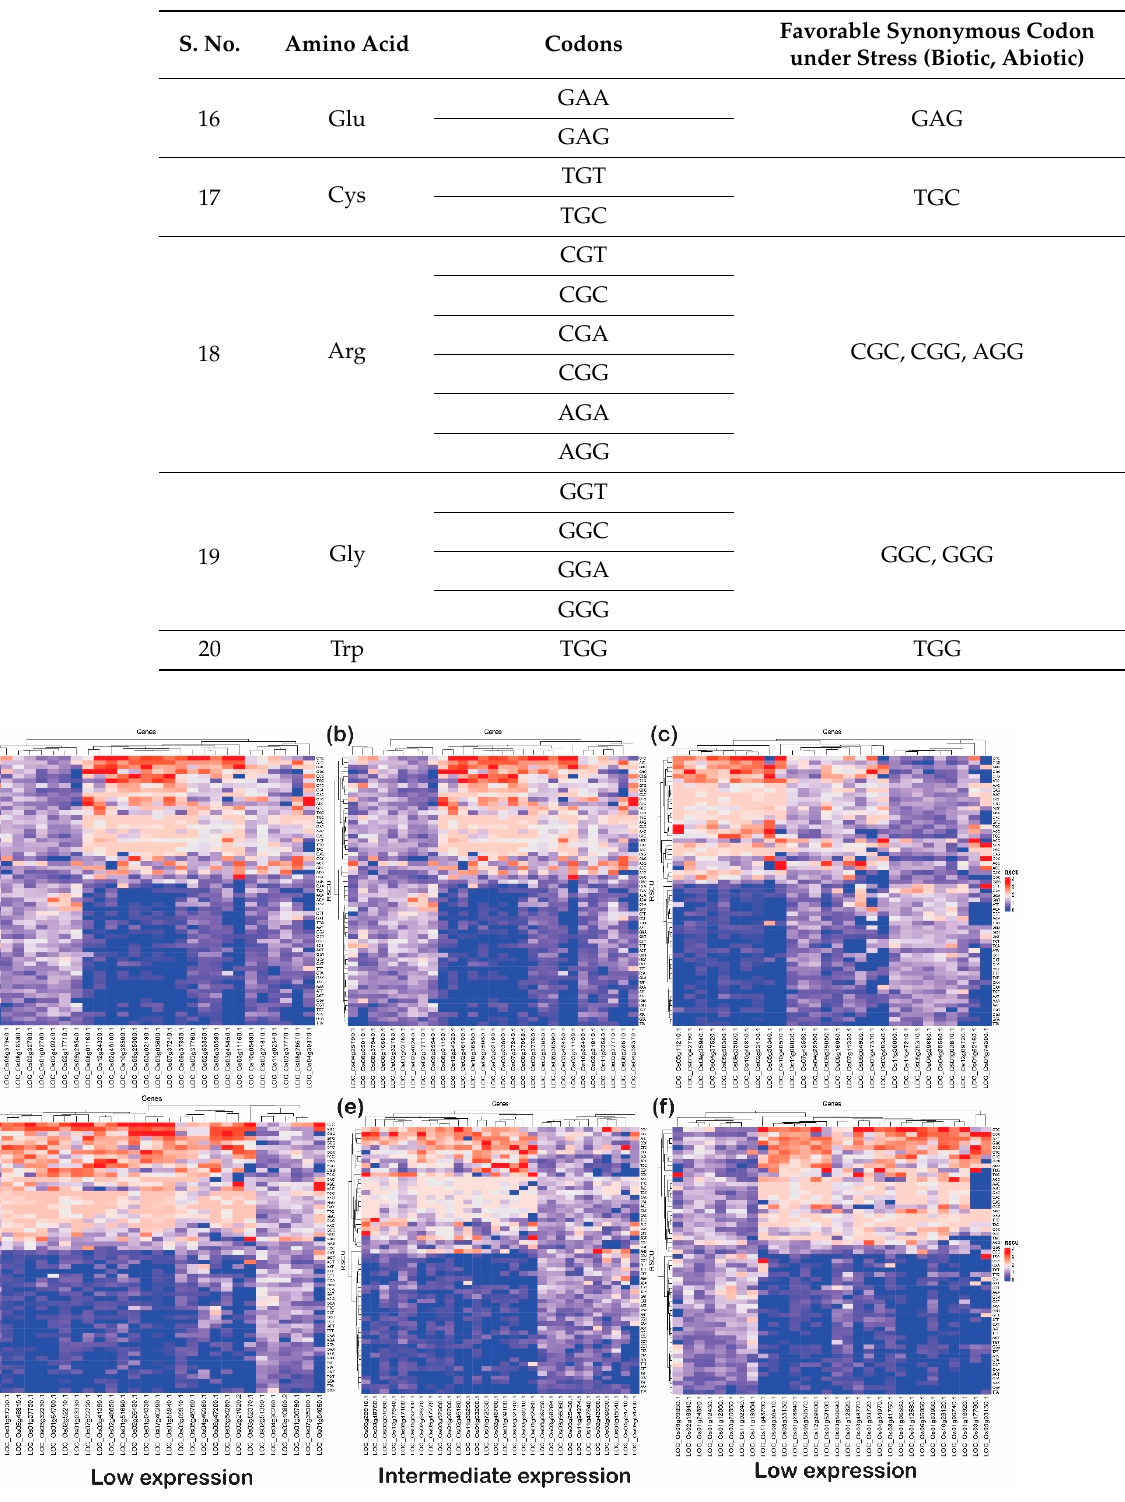
Figure 8. The heat plots of codon usage bias (CUB) under abiotic stress. The codon usage bias in the genes expressed under ( a ) low, ( b ) intermediate and ( c ) high gene expression categories for downregulated genes and CUB profile for ( d ) low-, ( e ) intermediate-, and ( f ) high-expressed genes for upregulated genes under abiotic stress condition in rice based on RSCU. The codons with AT at the third codon position are less biased than the codons with GC at the third nucleotide position.